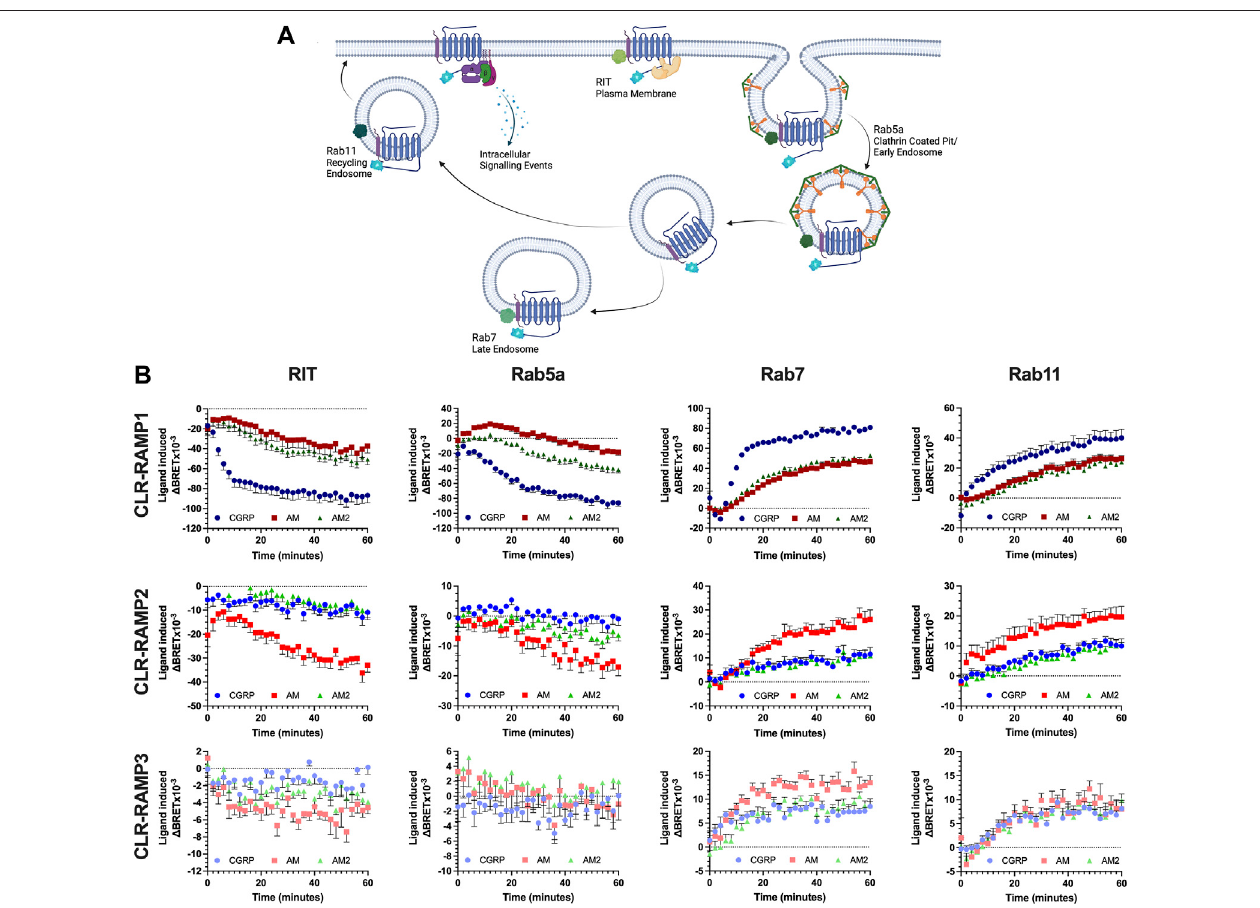
FIGURE 2 | CLR-RAMP1 in the only complex to undergo appreciable internalisation and traf fi cking, leading towards degradation. Schematic (created with BioRender.com)showingtheinternalisationand subcellulartraf fi ckingofCLRincomplexwithaRAMP,identifyingthedifferentmembraneGTPases used (A) .Changein colocalisation of CLR over 60 min stimulation with each peptide as determined in HEK293T cells, for RIT, Rab5a, Rab7, and Rab11 when in complex with RAMP1, RAMP2, and RAMP3 (B) . Data are shown as mean with error bars indicating the SEM of n repeats where n = 3 duplicates.